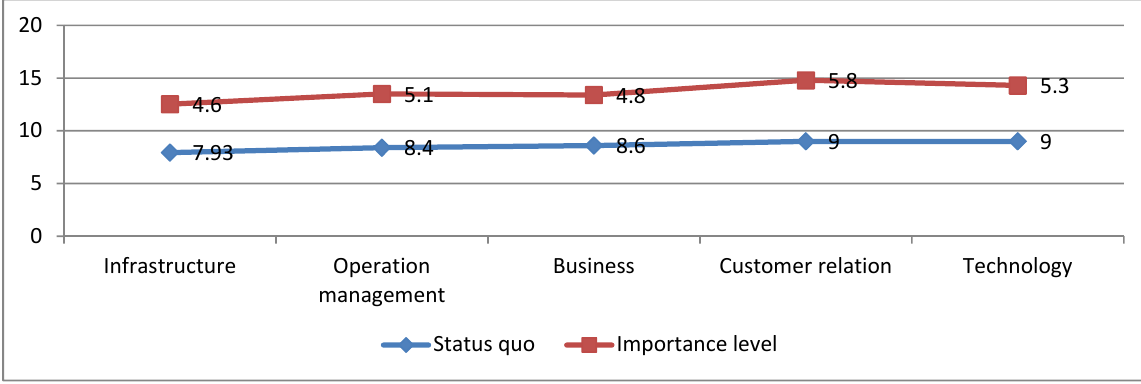
Fig. 6. The comparison between the as-is and to-be